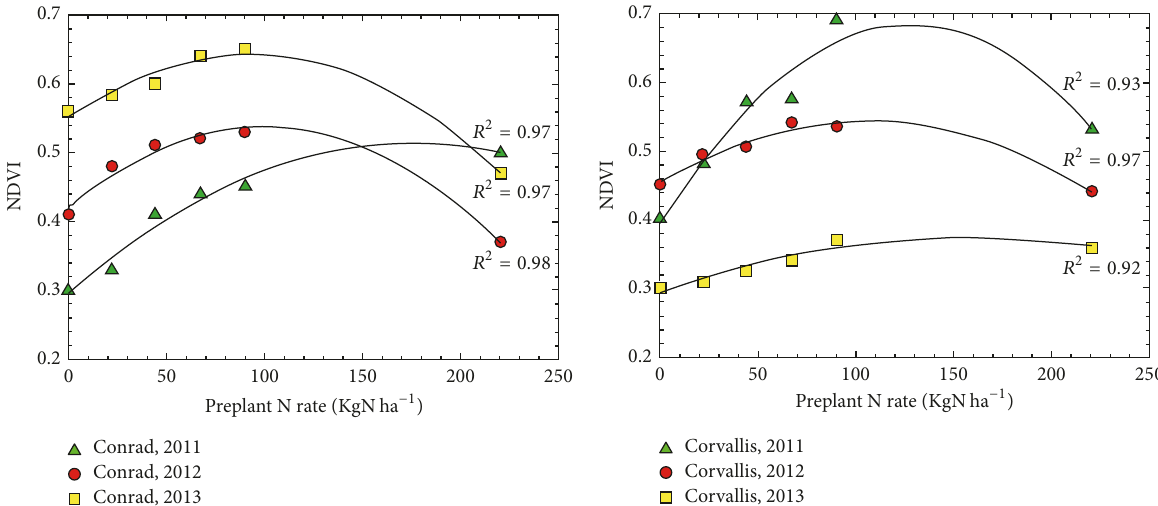
Figure 1: Relationships between Normalized Difference Vegetation Index (NDVI) and preplant N application rate for 2011, 2012, and 2013 at (a) Conrad and (b) Corvallis. Each data point represents the mean of four replications and was regressed against preplant N application